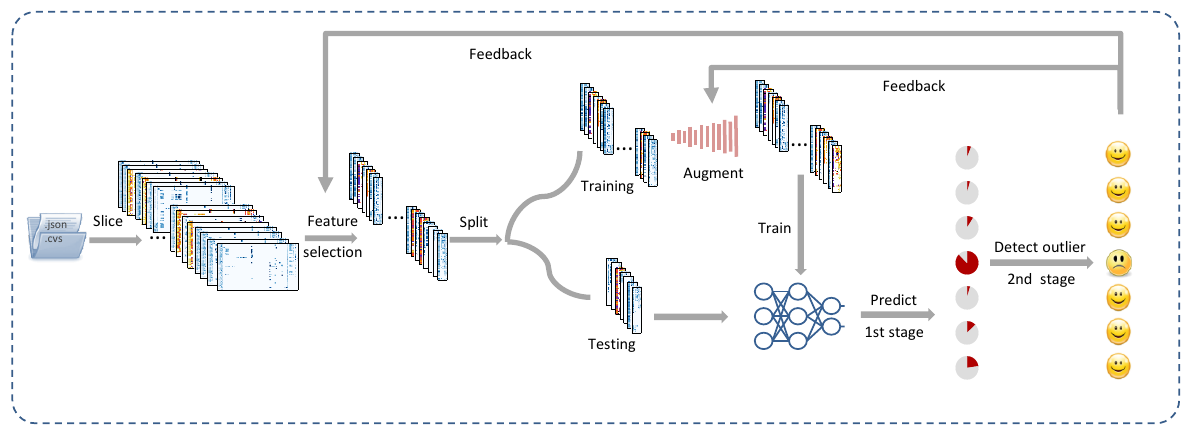
Figure 1. An overview of